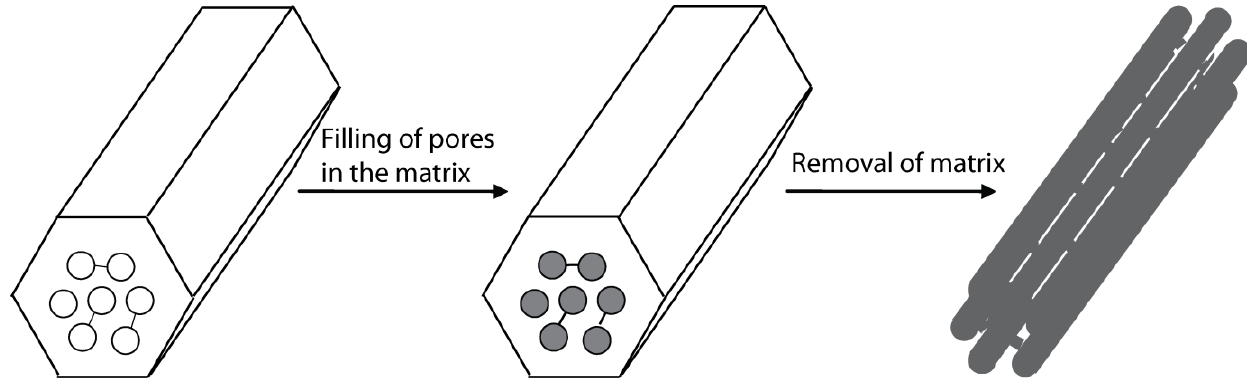
Figure 3. The replica method